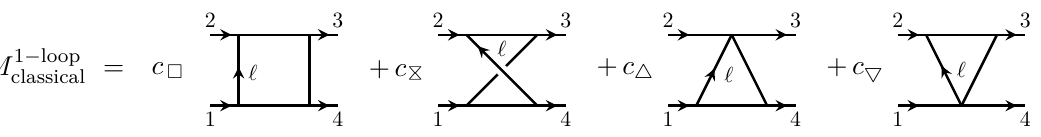
Figure 1. The relevant part of 1-loop amplitude contributes to classical effects. The diagrams are scalar integrals and c are their associated integral i